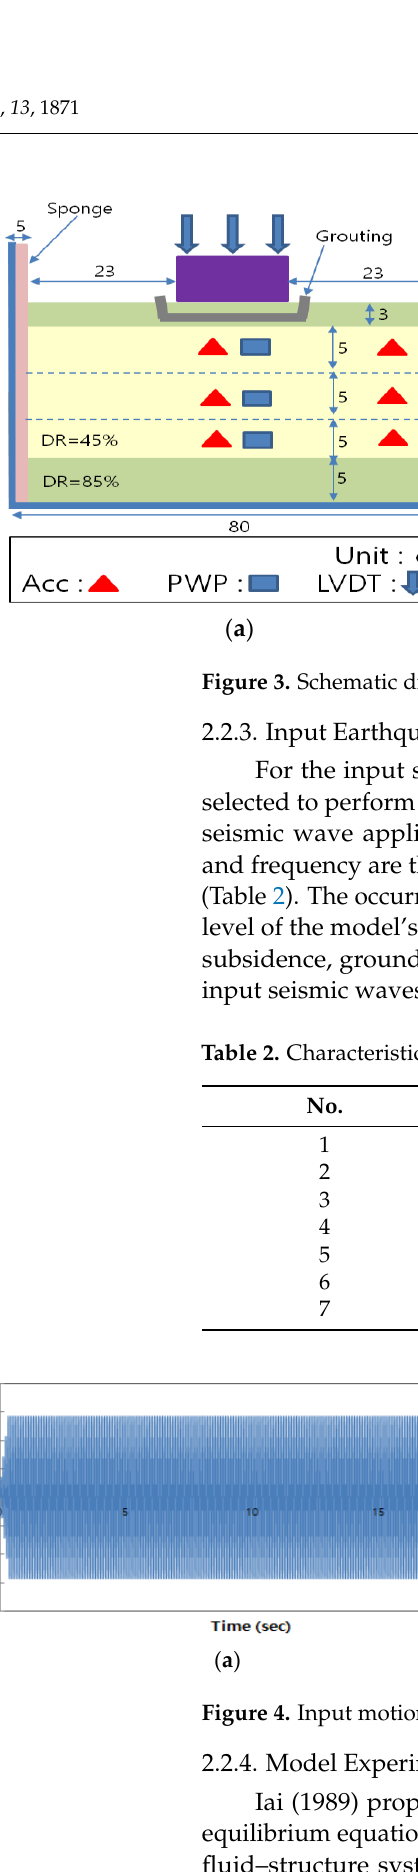
Figure 2. Particle distribution of Jumunjin standard sand.